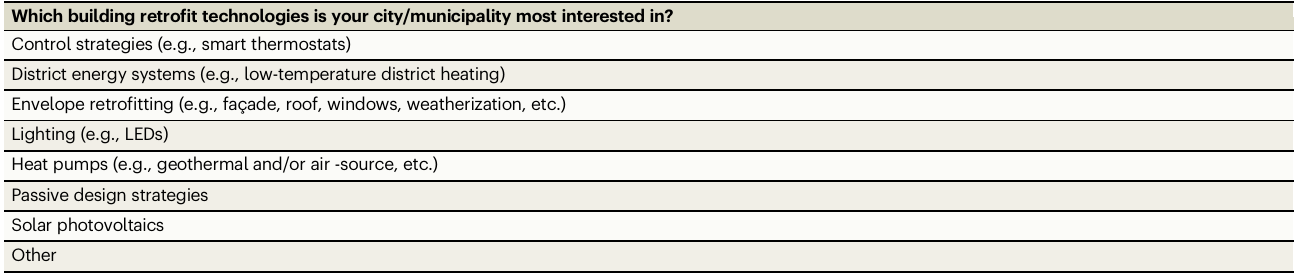
Table 3 | Pre-workshop survey questions provided to municipal representatives Which building retro fi t technologies is your city/municipality most interested in? Control strategies (e.g., smart thermostats) District energy systems (e.g., low-temperature district heating) Envelope retro fi tting (e.g., façade, roof, windows, weatherization, etc.) Lighting (e.g., LEDs)